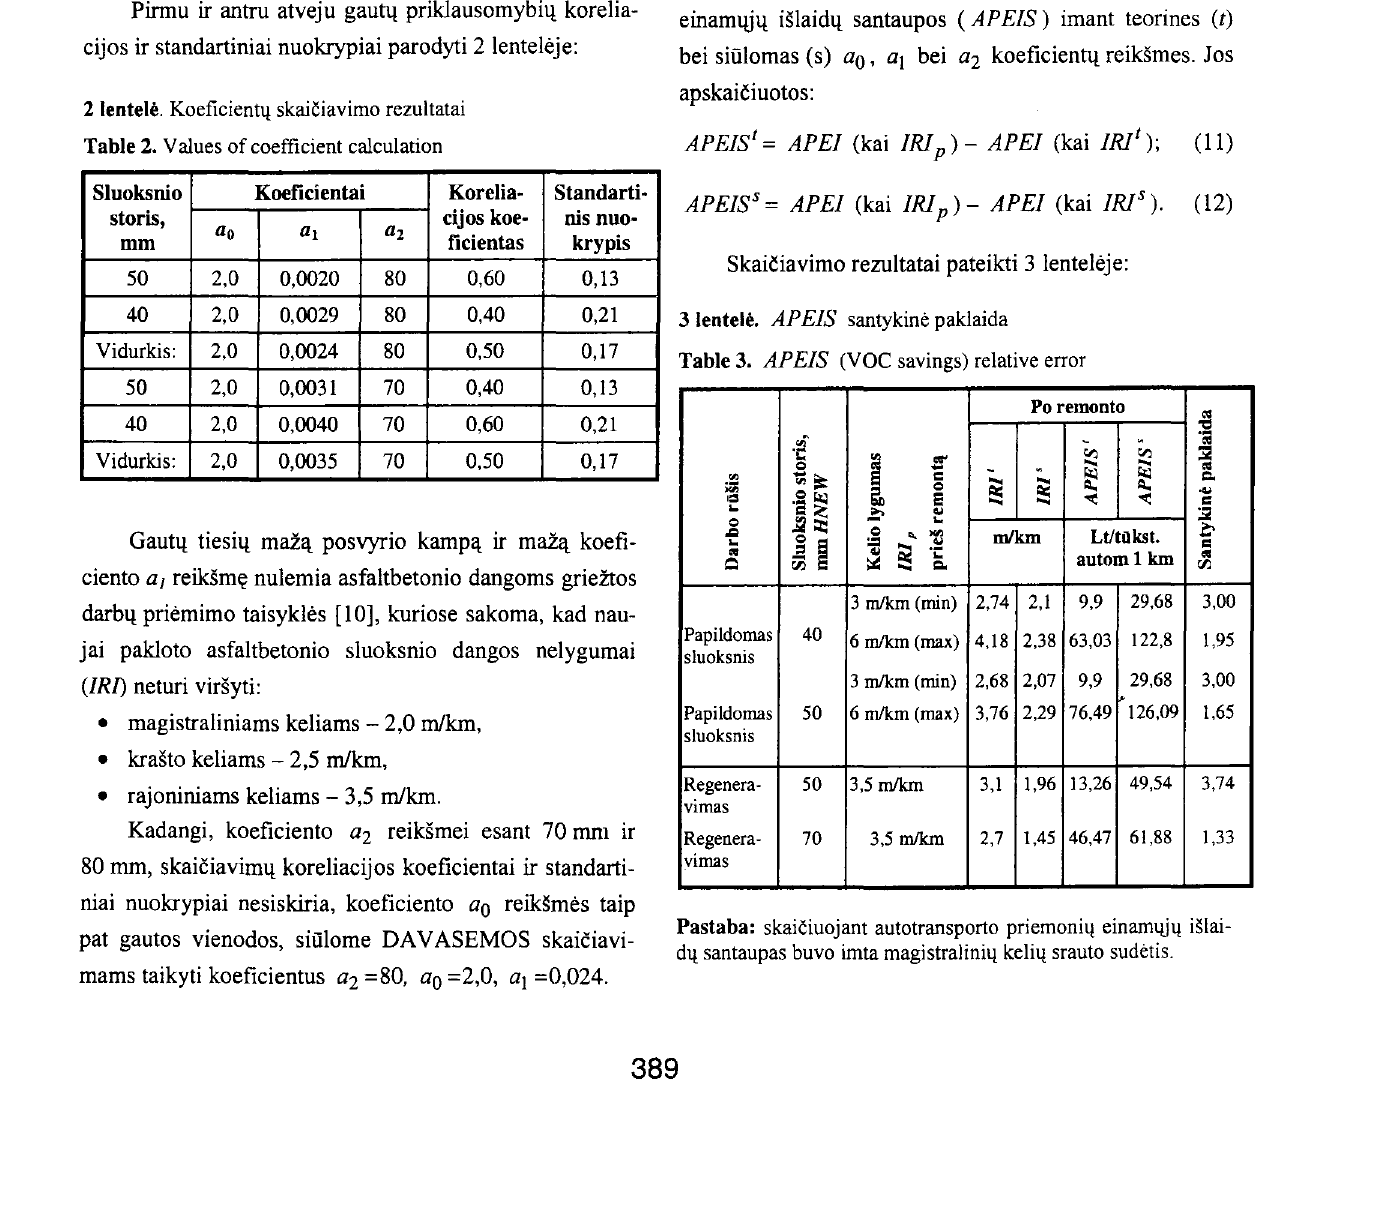
Table 2. Values of coefficient calculation